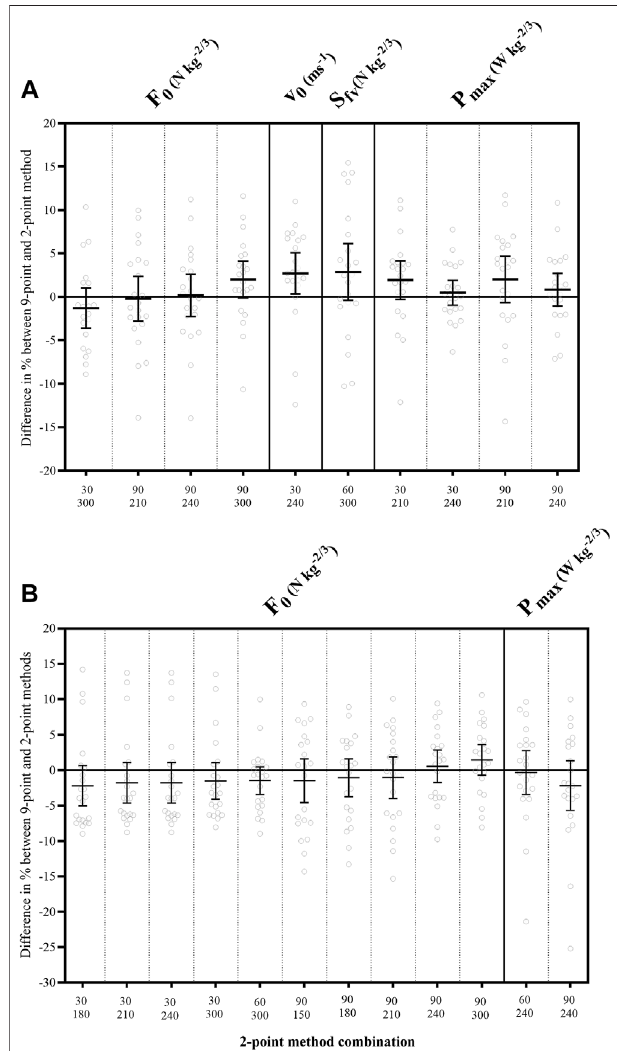
FIGURE 3 | Bland — Altman statistics for combination of the 2-point methods with the highest validity. (A) graph presents knee extension and (B) graph presents knee fl exion. Horizontal line shows mean bias — difference between the 2-point methods and 9-point method F-v parameters in %. Vertical red line shows 95% limits of agreement for bias. F 0 , maximal theoretical force; v 0 , maximal theoretical velocity; S fv , slope of force-velocity curve; P max , maximal theoretical power; N, Newtons; W, Watts; m, meters; s, andKF F 0 andisometric force ( r = 0.50 forthe polynomial; r =0.45for